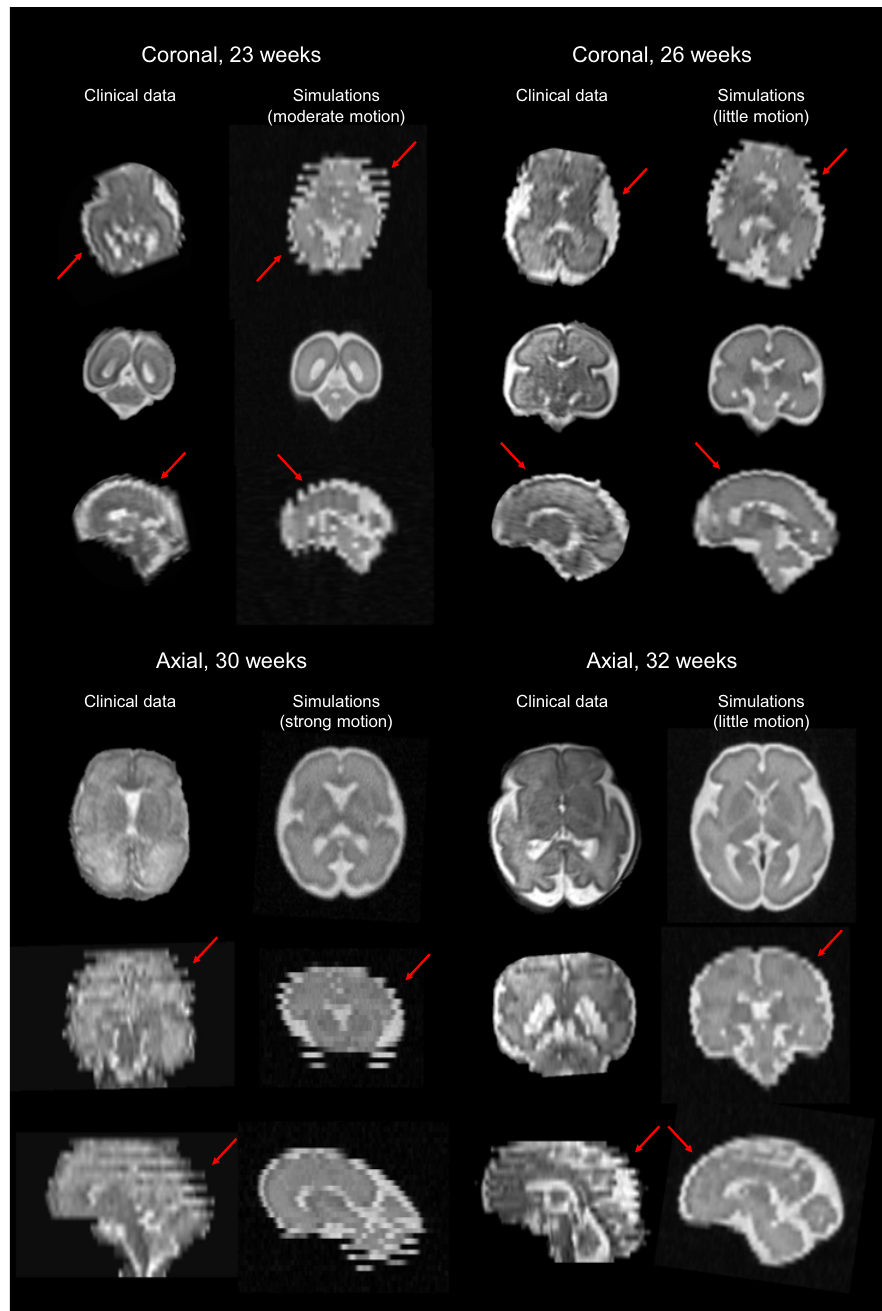
Figure 2. Visual inspection and comparison between clinical MR acquisitions and representative simulated HASTE images of the fetal brain in the three orthogonal orientations at four different GA (23, 26, 30 and 32 weeks). The amplitude of movement of the fetus is indicated from the motion index computation. Red arrows point out typical out-of-plane motion